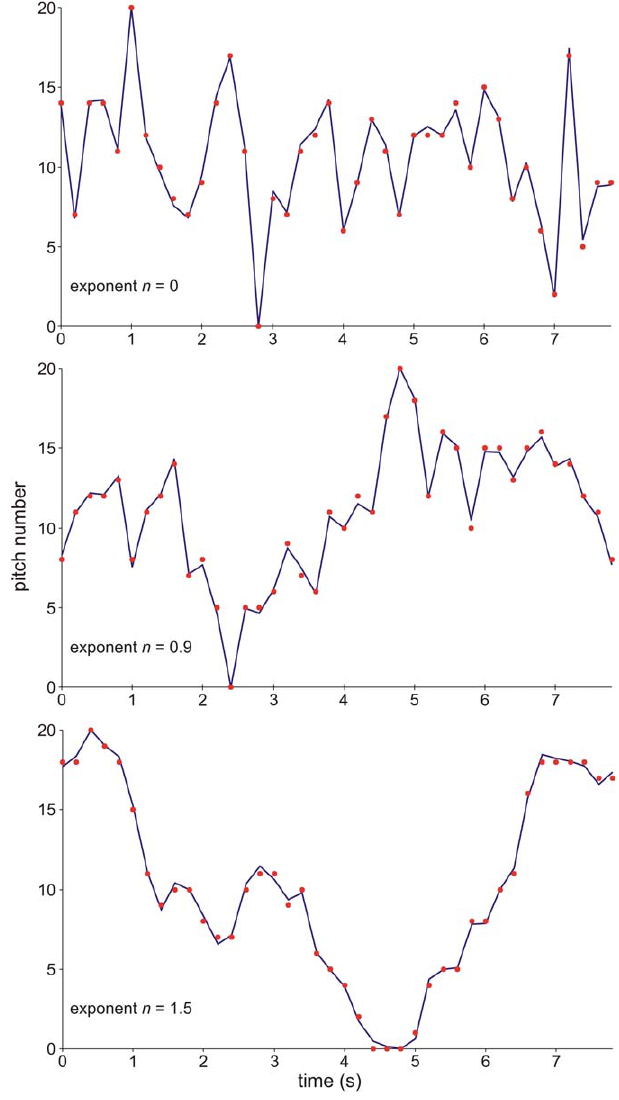
Figure 1. Stimuli Examples of fractal waveforms (blue) and the related pitch sequences (red, rounded to the nearest integer) based on inverse Fourier transforms of f –n power spectra, with exponent n ¼ 0 (top), n ¼ 0.9 (middle), n ¼ 1.5 (bottom). Equitempered pitch (ten-note octave, ranging over two octaves, resulting in 21 possible pitches, with ordinal indices 0 to 21 corresponding to 300–1,200 Hz) is denoted on the y -axis, time (in seconds) on the x -axis. Entropy is largest for the top pitch sequence and decreases as exponent n